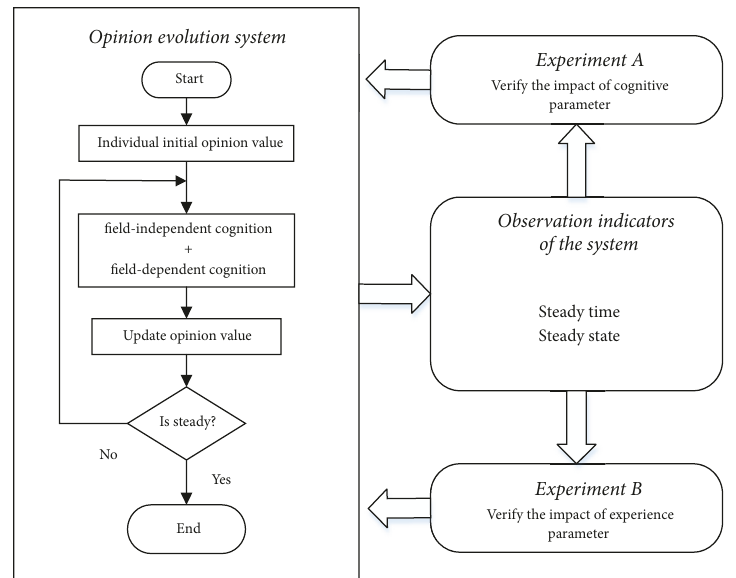
Figure 1: Block diagram of the simulation experiment